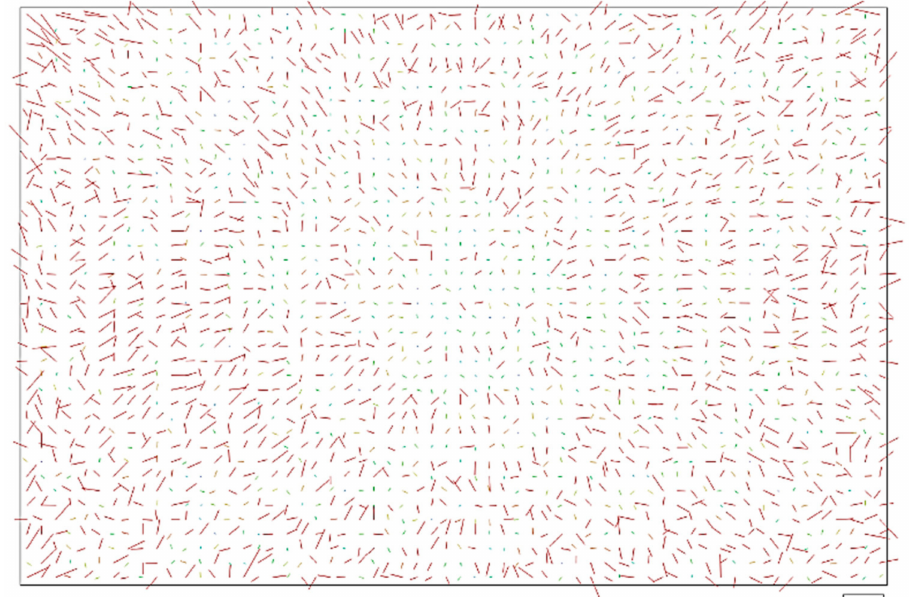
Figure 4. Example of image residuals across the area of the sensor. Magnification factor is 302 × . The scale bar outside the figure, at the bottom right corner, represents 1 micron. Camera pixel size is 3.63